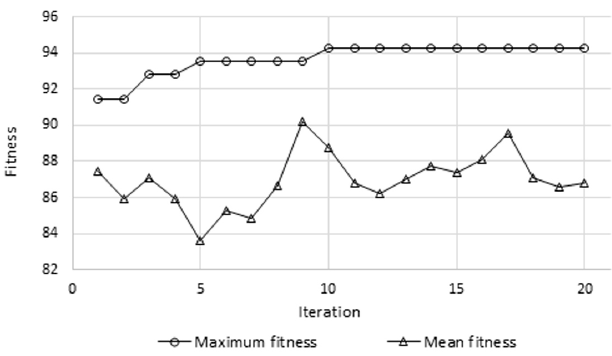
Figure 6. Mean and maximum fitness values at different iterations of the genetic algorithm.